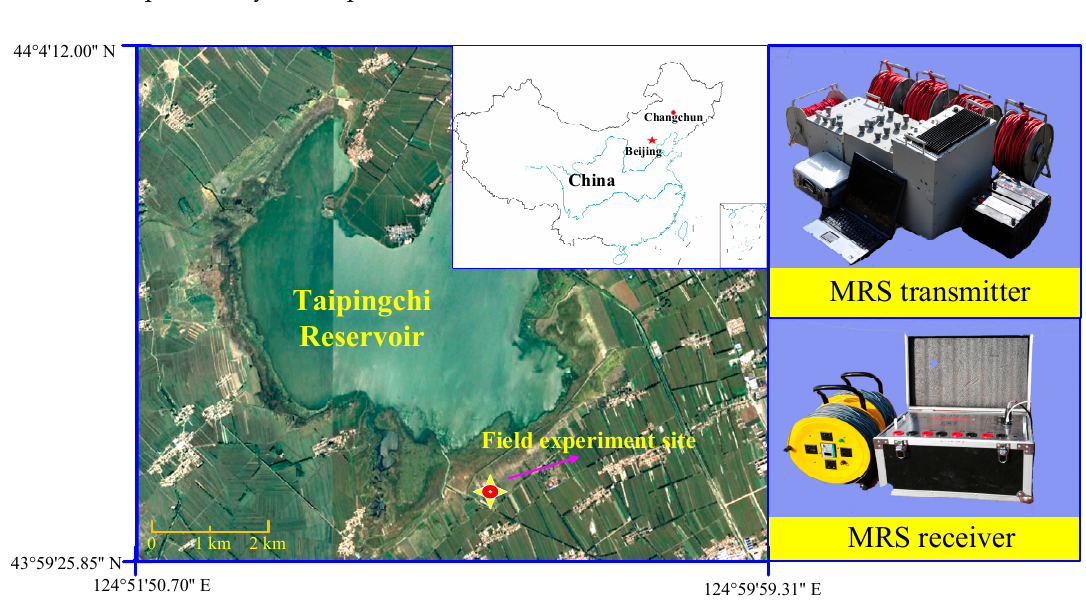
Figure 15. Field experiment location and the MRS instrument.